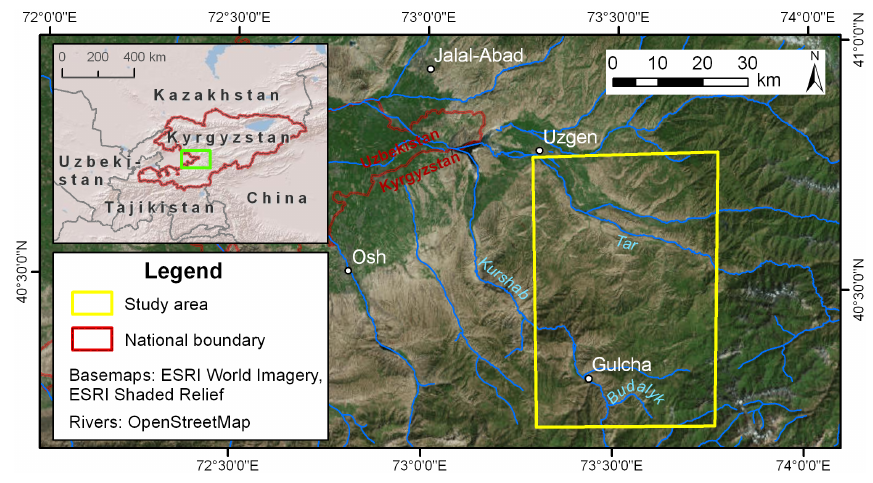
Figure 1. Location of the study